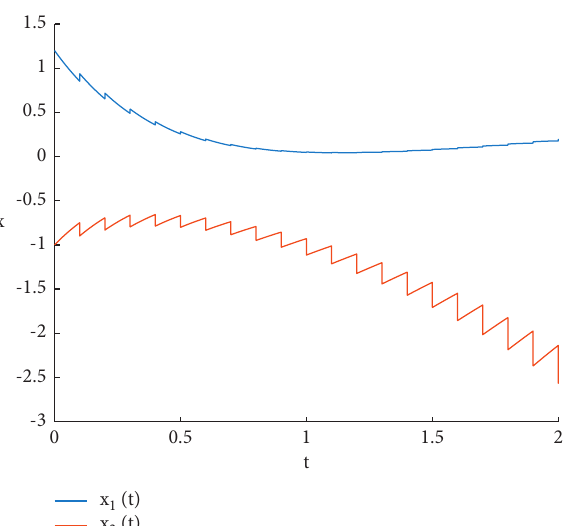
Figure 3: State trajectories x